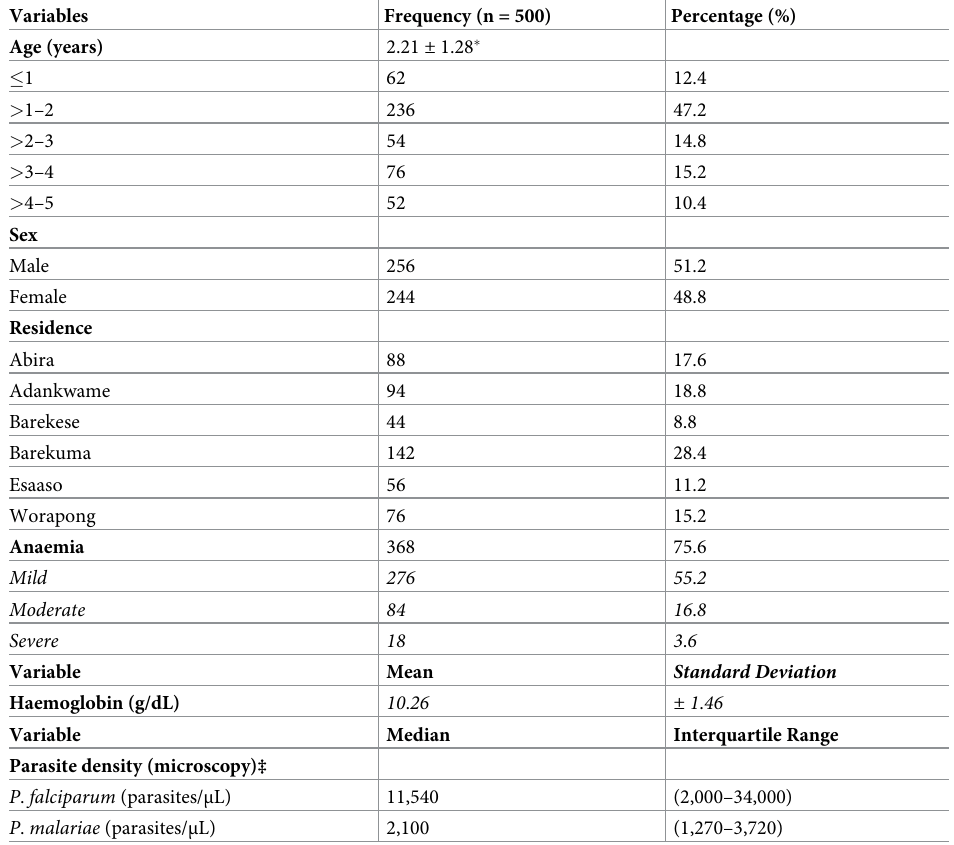
Table 2. Baseline characteristics of the study